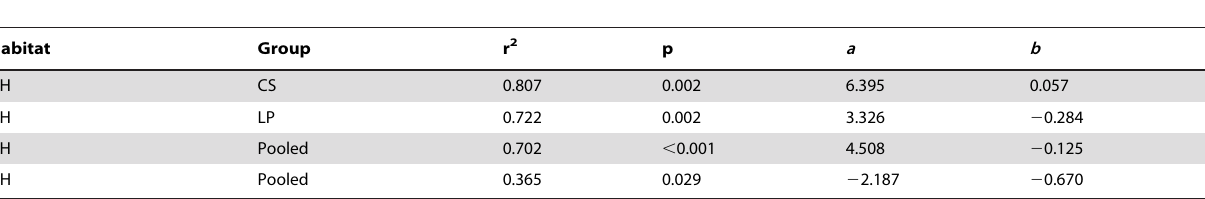
Table 2. Summary of phylogenetically independent comparative analysis (PICs) for the relationships between sprout number and seed size of the climax species (CS) and long-lived pioneers (LP) studied, and for the pooled data (Pooled) of the two groups.